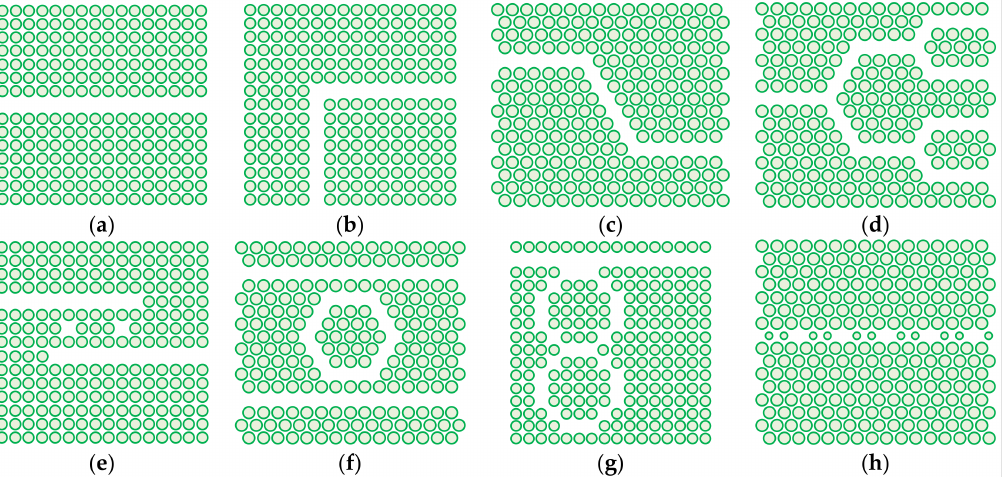
Figure 6. Some passive waveguide-based components in 2D photonic crystal nanomembranes, top view. ( a ) Line defect waveguide; ( b ) 90 ◦ channel waveguide in rectangular lattice; ( c ) 60 ◦ channel waveguide in triangular lattice; ( d ) two-stage Y-splitter; ( e ) cavity-based wavelength division multi- plexer; ( f ) ring resonator with single loop in triangular lattice; ( g ) ring resonator in rectangular lattice with two loops in vertical layout; ( h ) coupled-resonator optical waveguide in triangular